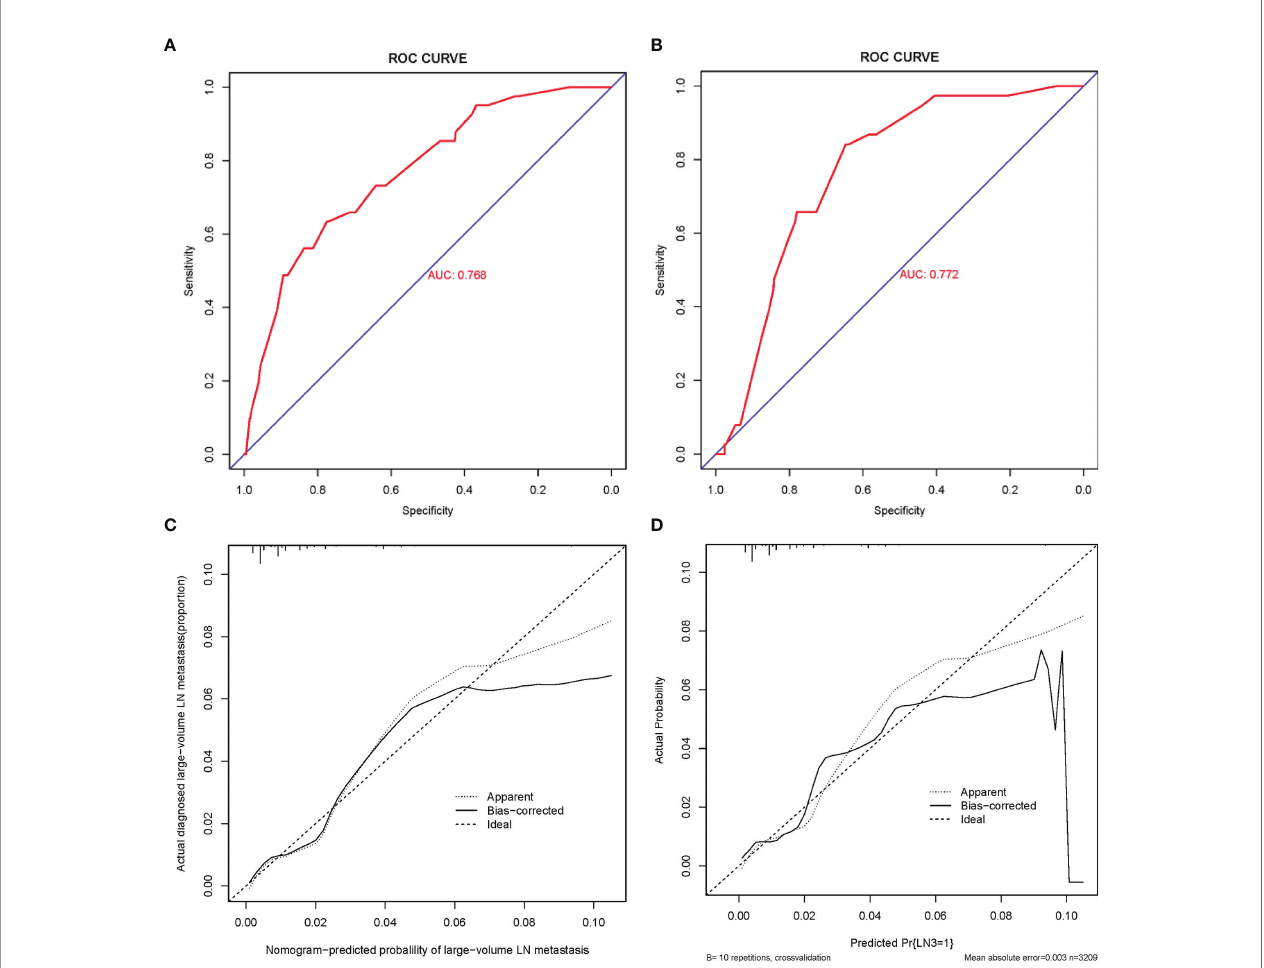
FIGURE 4 | ROC curve and calibration curves of the nomogram for predicting large-number LNM in PTMC patients. (A) ROC curve for the training set. (B) ROC curve for the external testing set. AUC, area under ROC curve; ROC, receiver operating characteristic. (C) Calibration curve of the nomogram for the internal testing set. (D) Calibration curve of the nomogram for the external testing set. The x-axis represents the predicted large-number LNM. The y-axis represents the actual large-number LNM. The diagonal dotted line stands for a perfect prediction using an ideal model. We drew the solid line to represent the performance of the nomogram, of which the closer fi t to the diagonal dotted line represents the better prediction of the